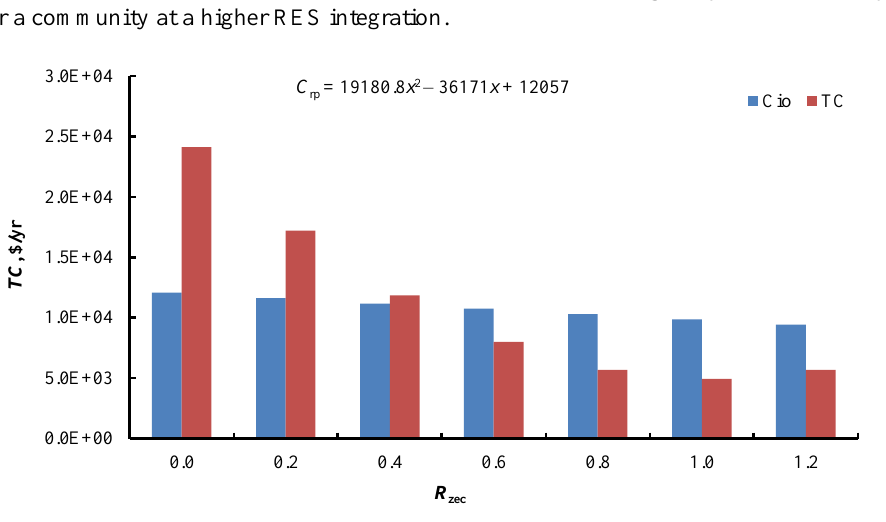
Fig. 4. The total cost of the community under